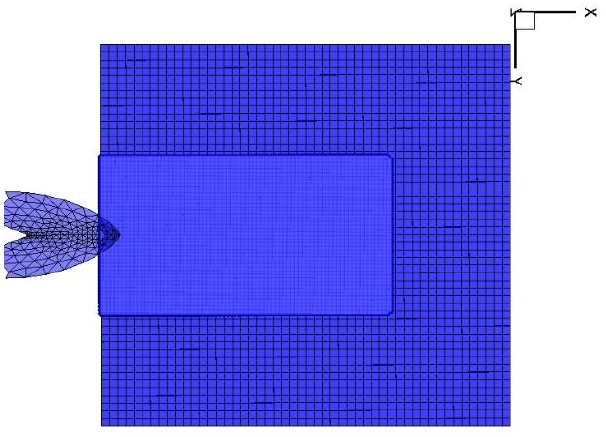
Figure 10. Numerical model of ship-ice interaction.